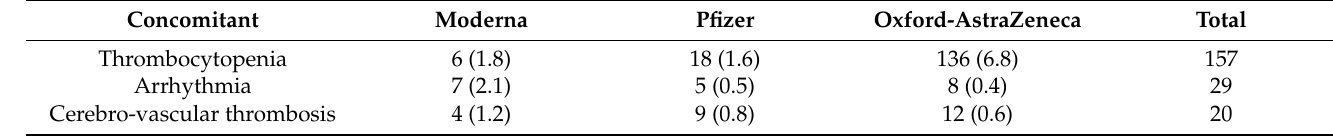
Table 5. Concomitant clinical conditions and other thrombotic adverse